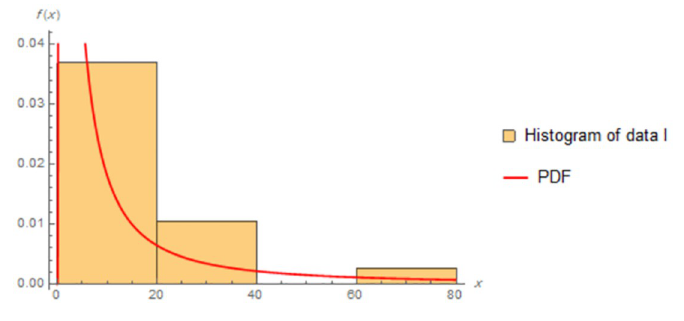
Fig 6. Estimated PDF of data I.